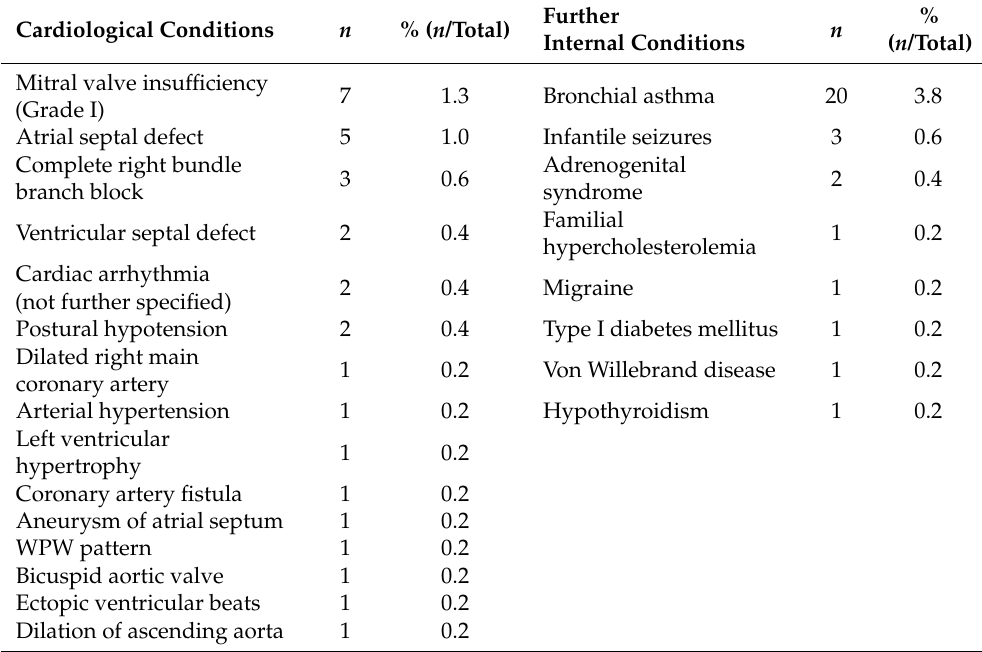
Table 4. Cardiological and further internal conditions among the participants, indicated as number of cases ( n ), ordered by frequency, and given as a percentage of the total study population (%).